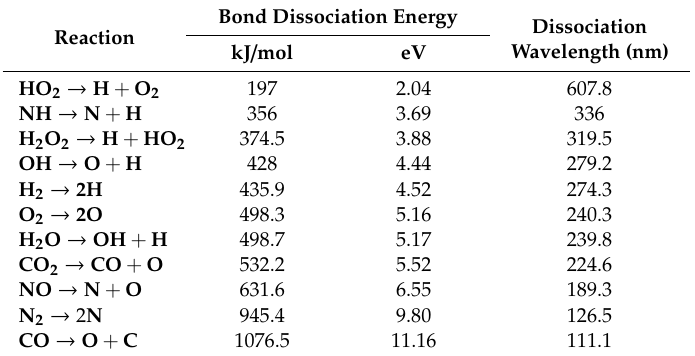
Table 6. Bond dissociation energies for biologically relevant molecules